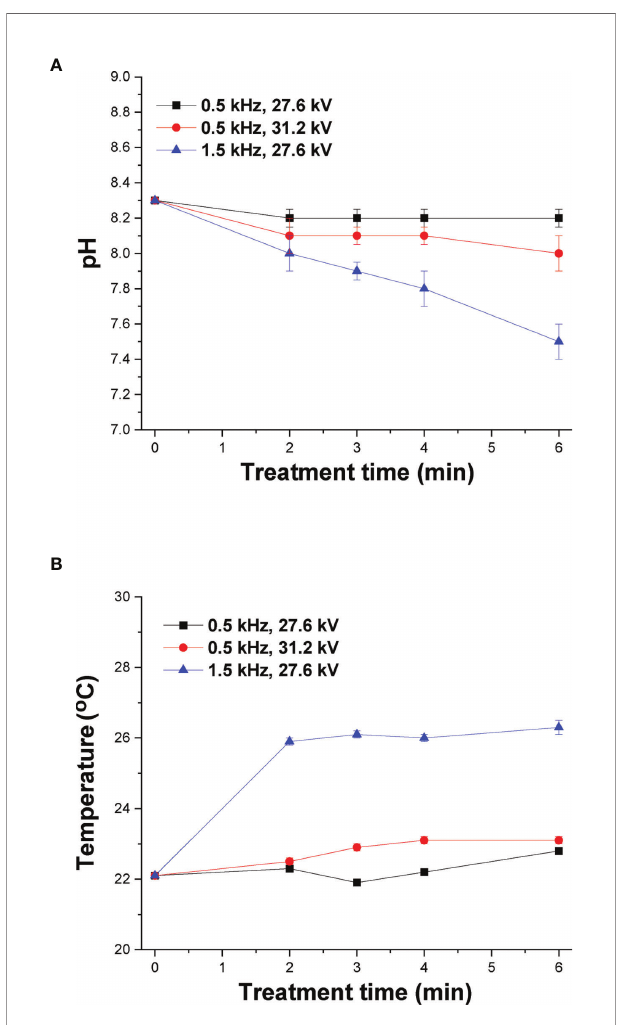
FIGURE 4 | DBD-CAP treatment does not affect cell cultured medium pH and temperature. Effect of plasma exposure time on (A) pH and (B) temperature of cell-free culture media (DMEM with 10% FBS) at different pulse voltages and frequencies of the NSP-DBD device. The values represent the mean ± SD of 3 (at least) independent